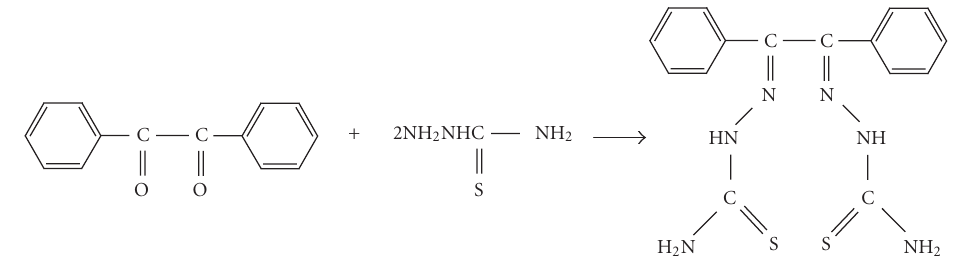
Figure 1: Synthesis and structure of